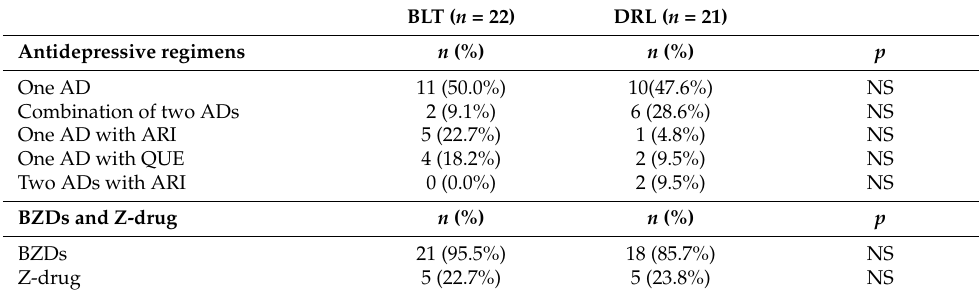
Table 2. Pharmacologic treatment with antidepressive regimens and